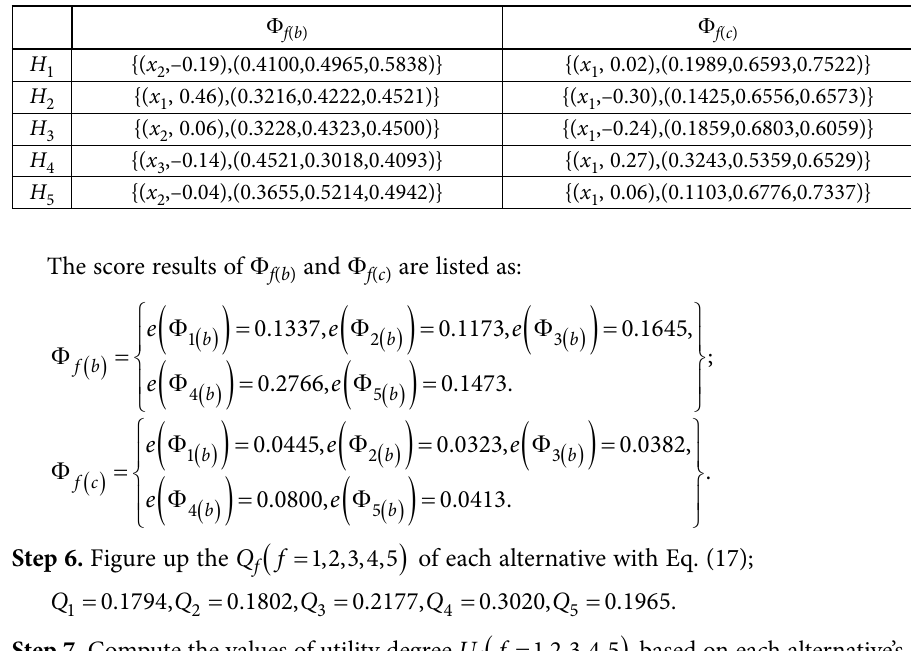
Table 6. The calculated results of F f ( b ) and F f ( c